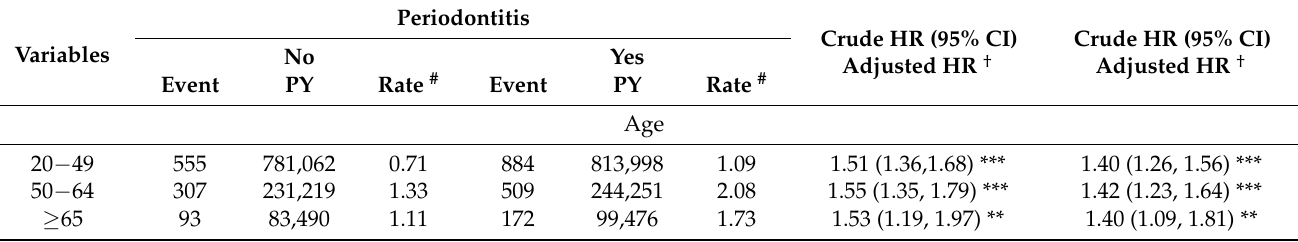
Table 3. Incidences and hazard ratios of gastric Helicobacter pylori for individuals with and without periodontitis.